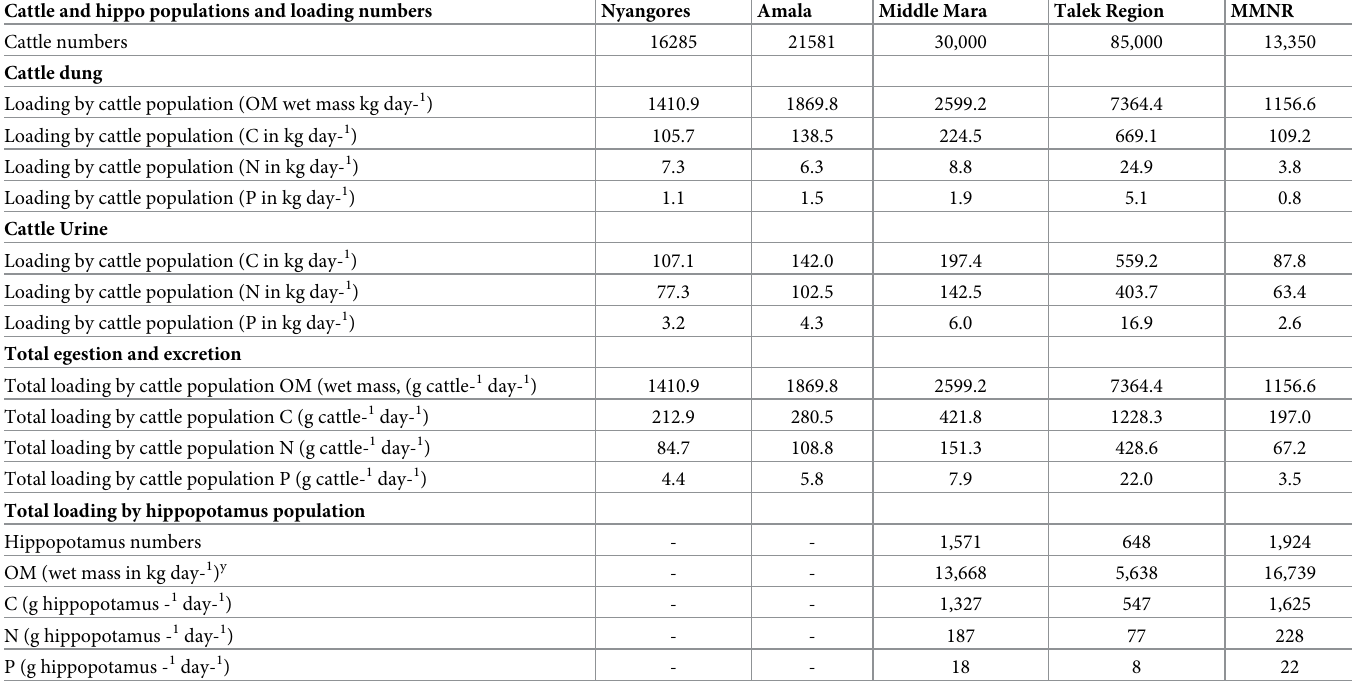
Table 5. Median loading rates of organic matter (dung) and nutrients (C, N and P) by cattle in the Mara River basin based on the metabolism model in comparison with published loading rates for hippopotamus. Cattle and hippo populations and loading